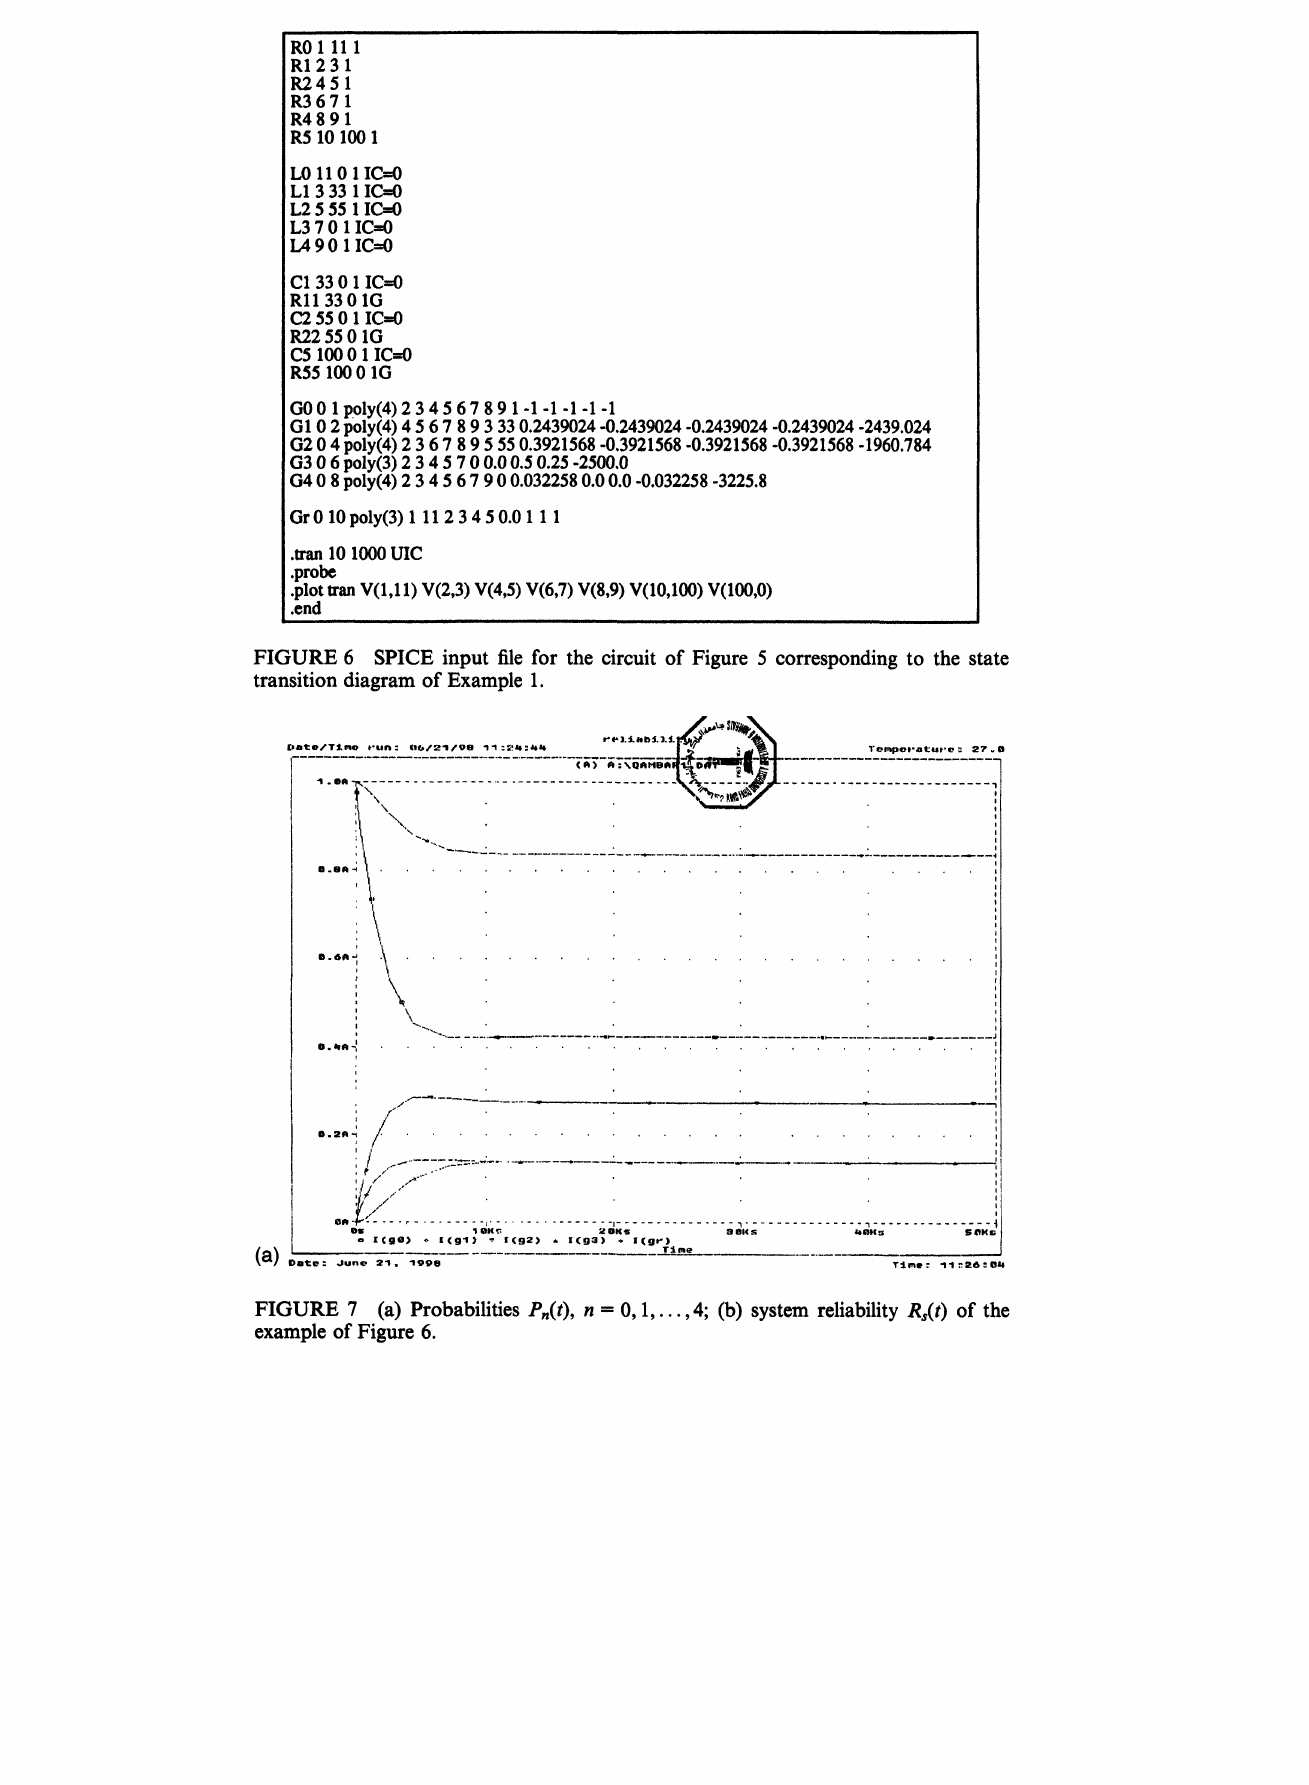
FIGURE 6 SPICE input file for the circuit of Figure 5 corresponding to the state transition diagram of Example 1.